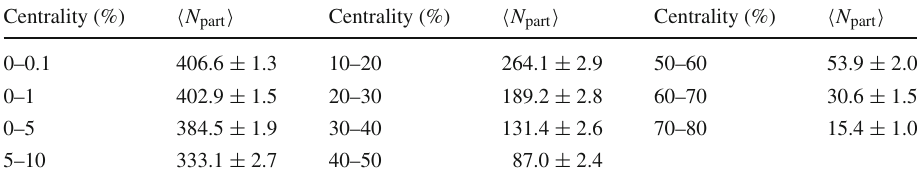
between centrality intervals used in the analysis and (cid:3) N part (cid:4)